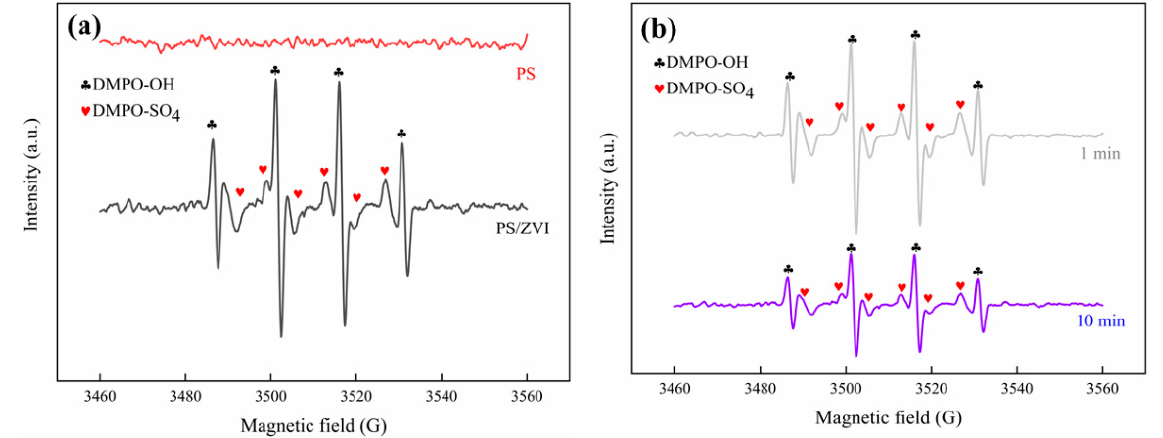
Figure 7. EPR spectra: ( a ) PS single and adopting ZVI/PS system; and ( b ) at various reaction times under ZVI/PS system. Experimental conditions: [PS] = 10 mM; [ZVI] = 1 mg/mL; [DMPO] = 50 mM; no pH adjustment.